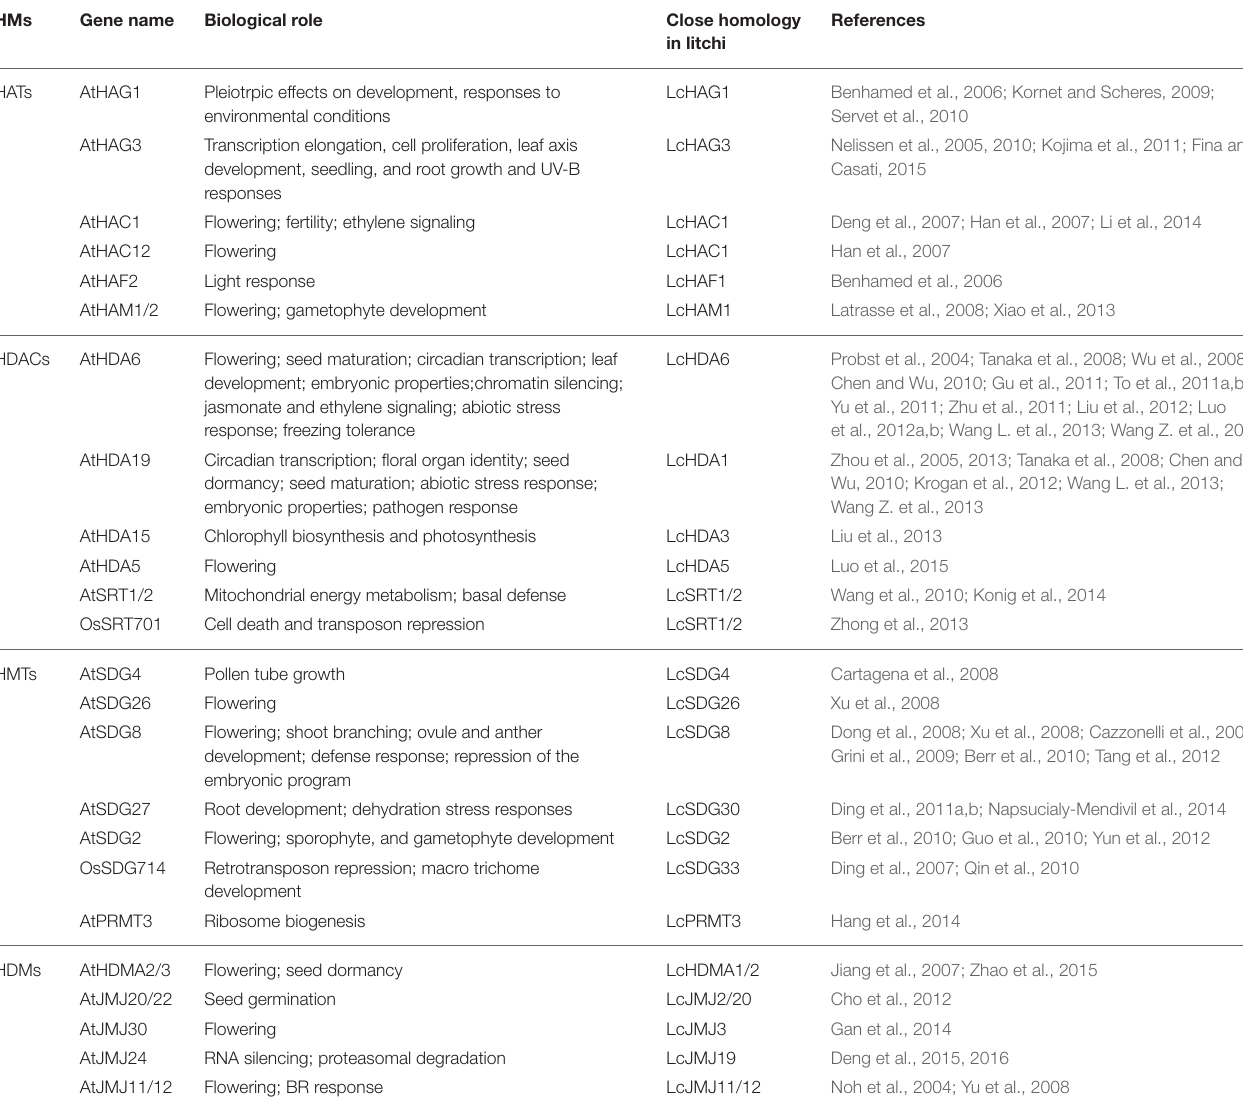
TABLE 1 | Histone midifiers functionally characterized in plants and their closest orthologs in litchi.